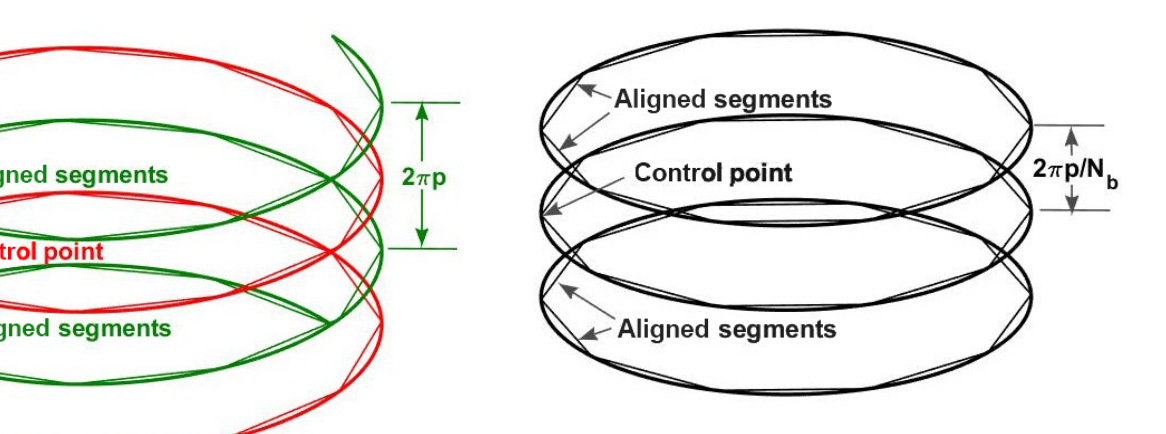
Figure 2. Vortex ring representation of the helical wake in Fig. 1 and the corresponding vortex segment